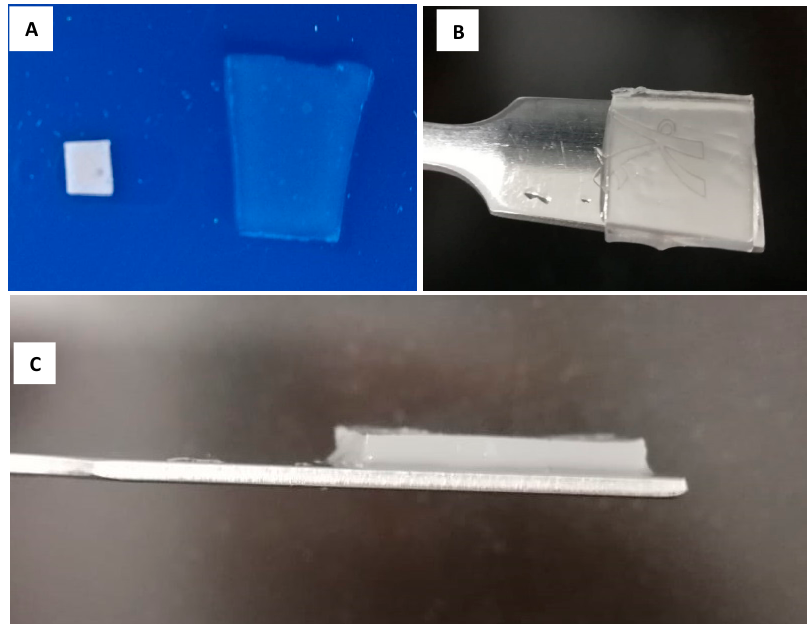
Figure 2. Images showing ( A ) dry (left) and swollen (right) HA5-PT20 Hydrogel films. ( B ) Closer view of a swollen HA5-PT20 Hydrogel film, and ( C ) side view of the thickness of the swollen HA5-PT20 hydrogel film.